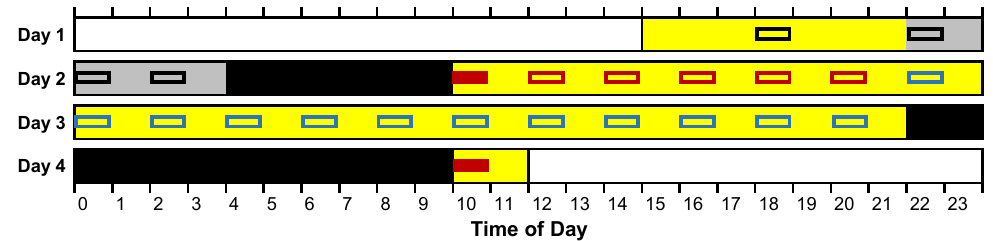
Figure 1. Schematic of the laboratory sessions. Yellow segments indicate scheduled wakefulness with neurobehavioral testing; black segments indicate scheduled sleep; and the grey segment indicates scheduled sleep in the prior sleep extension (PSE) condition and wakefulness with neurobehavioral testing in the prior sleep restriction (PSR) condition. Colored boxes denote 60-min neurobehavioral test bouts. Sleep inertia (SI) was quantified using sleepiness measured in the test bouts immediately after awakening marked with solid red boxes, relative to baseline sleepiness as averaged over the test bouts marked with open red boxes. Response to total sleep deprivation was assessed as the average of sleepiness measured in the test bouts marked with open blue boxes (from the PSE condition only). Open black boxes were not used for analyses. Participants underwent the schedule in this schematic three times—twice in the PSE condition and once in the PSR